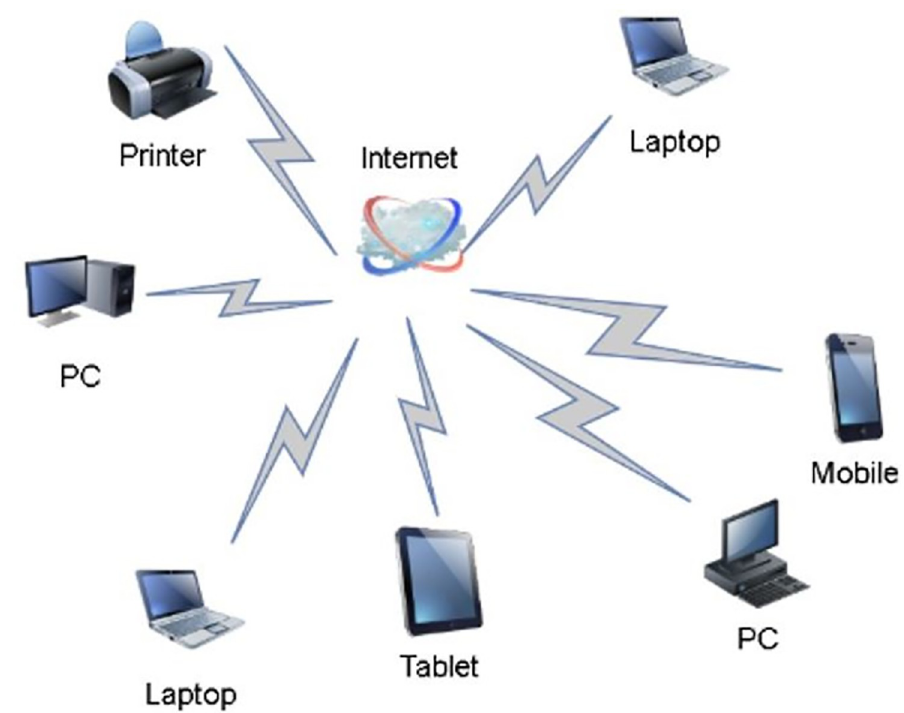
Fig 14. Percentage of packet loss ratio.